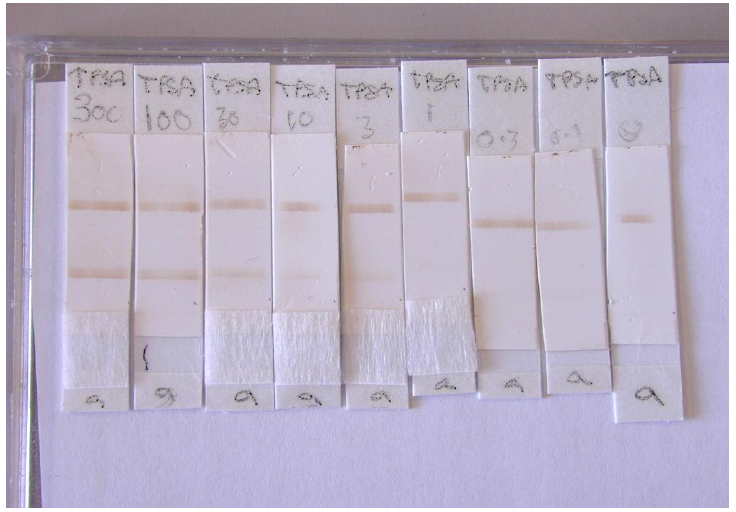
Figure 4. Photograph of the total PSA lateral flow assay.